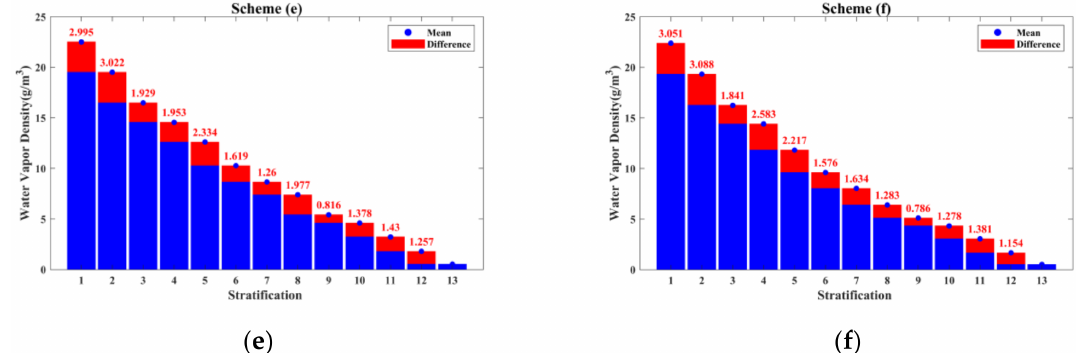
Figure 4. Mean water vapor density of each stratification and difference value between two adjacent stratifications derived from six stratification schemes, where ( a ) derived from uniform stratification; ( b – f ) derived from ANES with minimum height intervals of 350, 375, 400, 425 and 450 m,